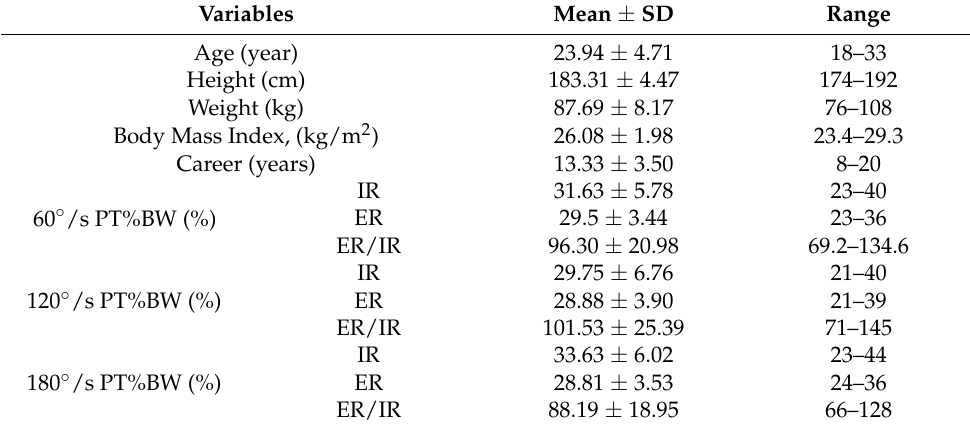
Table 1. Characteristics of the